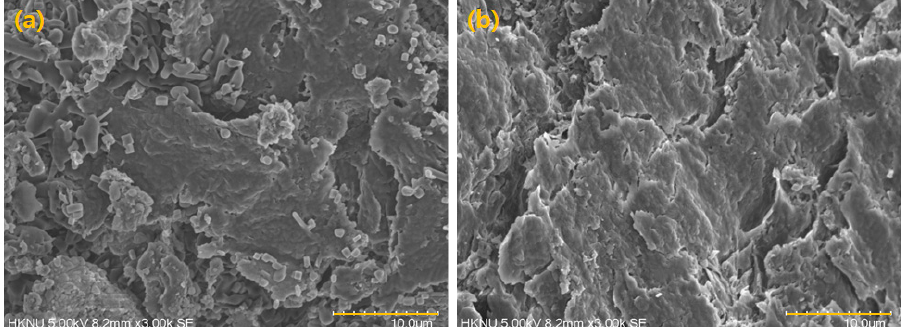
Figure 3. FE-SEM image of ( a ) untreated H. fusiformis and ( b ) H. fusiformis treated with 1 M NaOH (Scale bar: 10 µm). (Scale bar: 10 µ